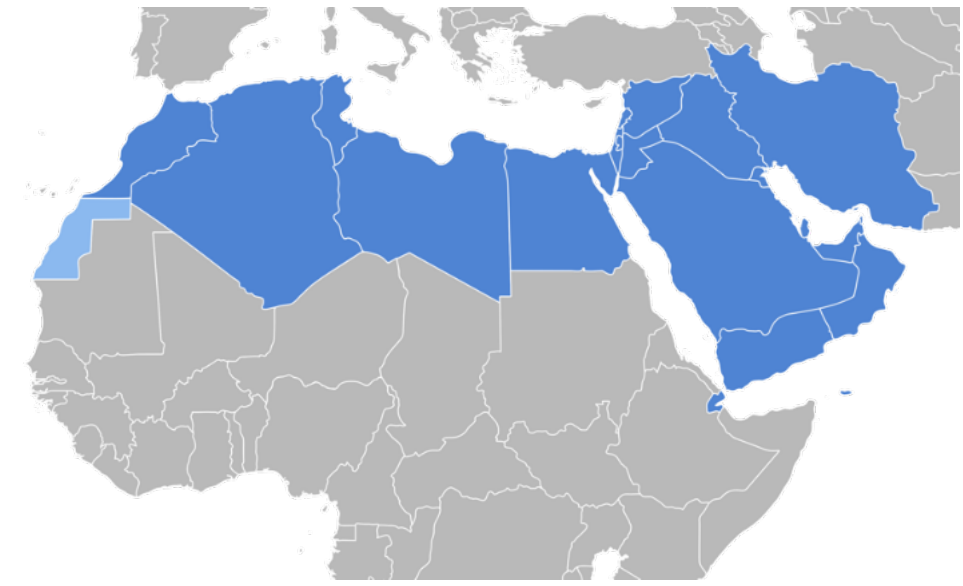
Figure 7. Depiction of the MENA region (in blue)